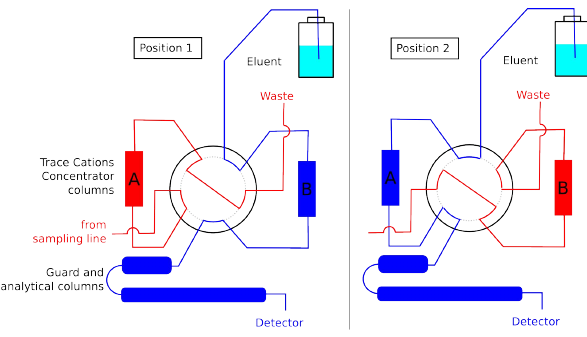
Fig. 2. Schematic of the concentrating system with two columns and a 10-port valve to ensure continuous measurements. While one column concentrates the analytes coming from the chamber sam- pling line (red line), the other column can be eluted and the sample analysed by ion chromatography (blue